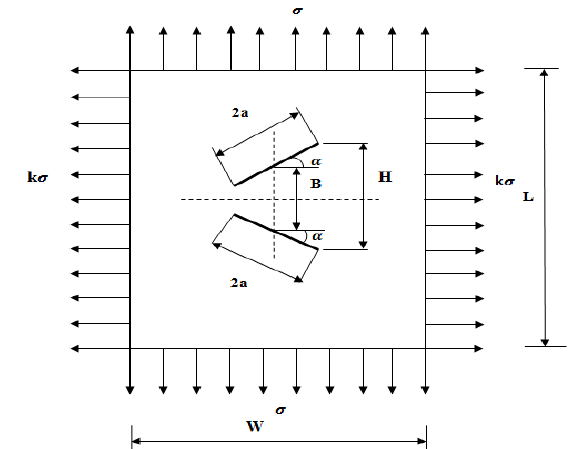
Figure 2: Specimen geometry of two parallel central inclined cracks.